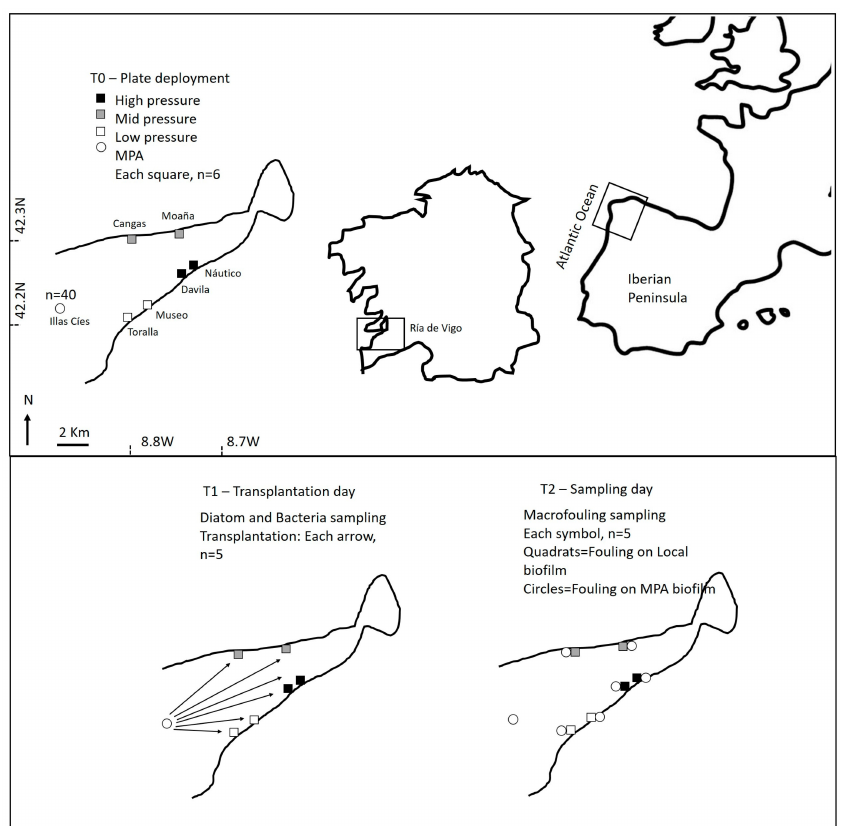
Figure 7. Location of the selected marinas at the R í a de Vigo (NW Iberian Peninsula), and scheme showing the details of experimental procedure and sampling performed during the di ff erent phases (T0, T1 and